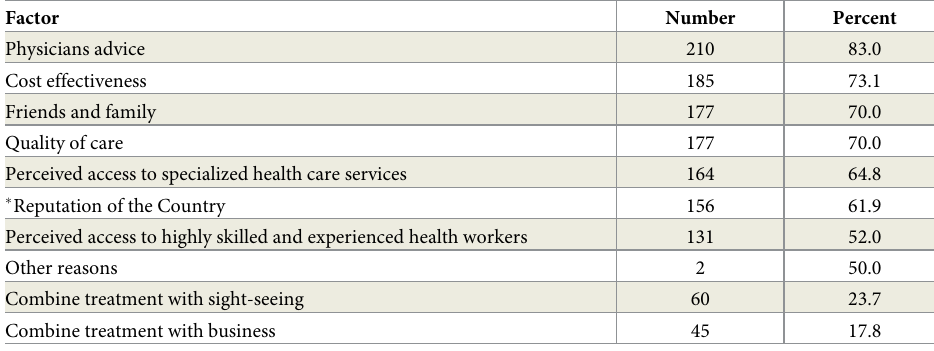
Table 2. Reasons given for choice of country for cancer